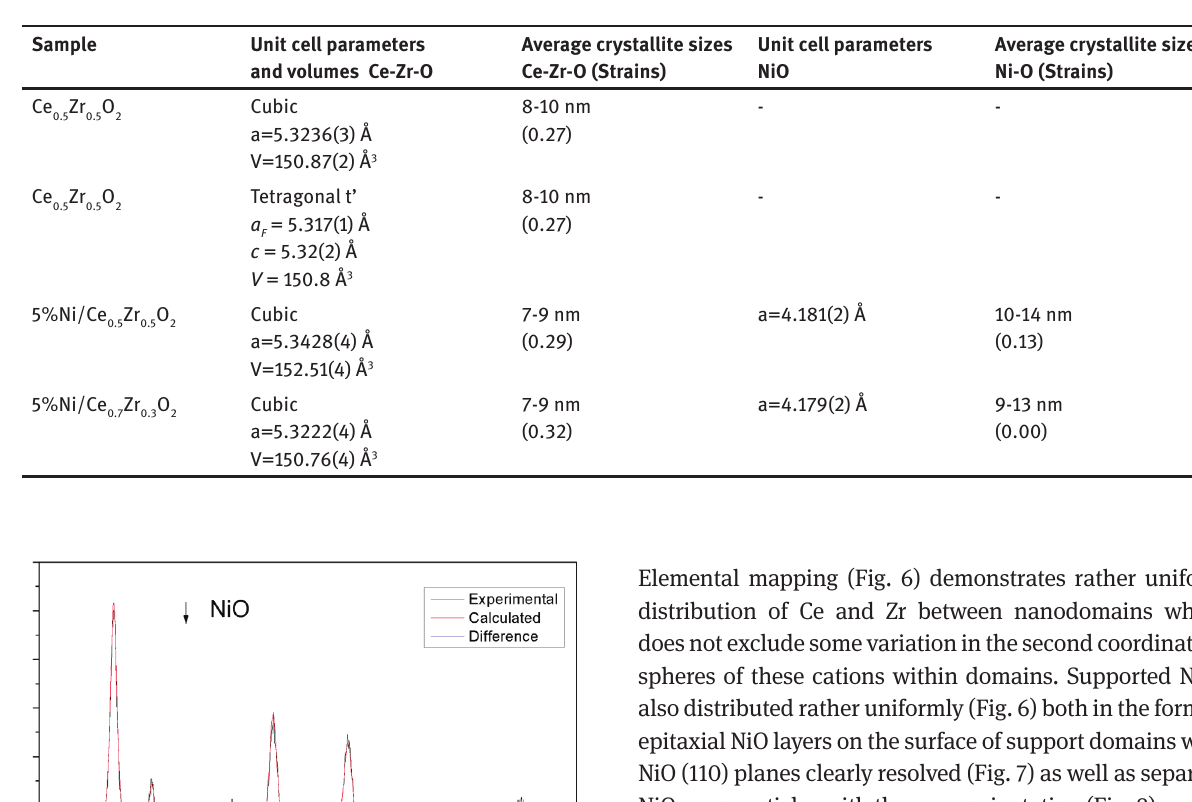
Figure 4: Full-profile Rietveld refinement for the 5%Ni/Ce